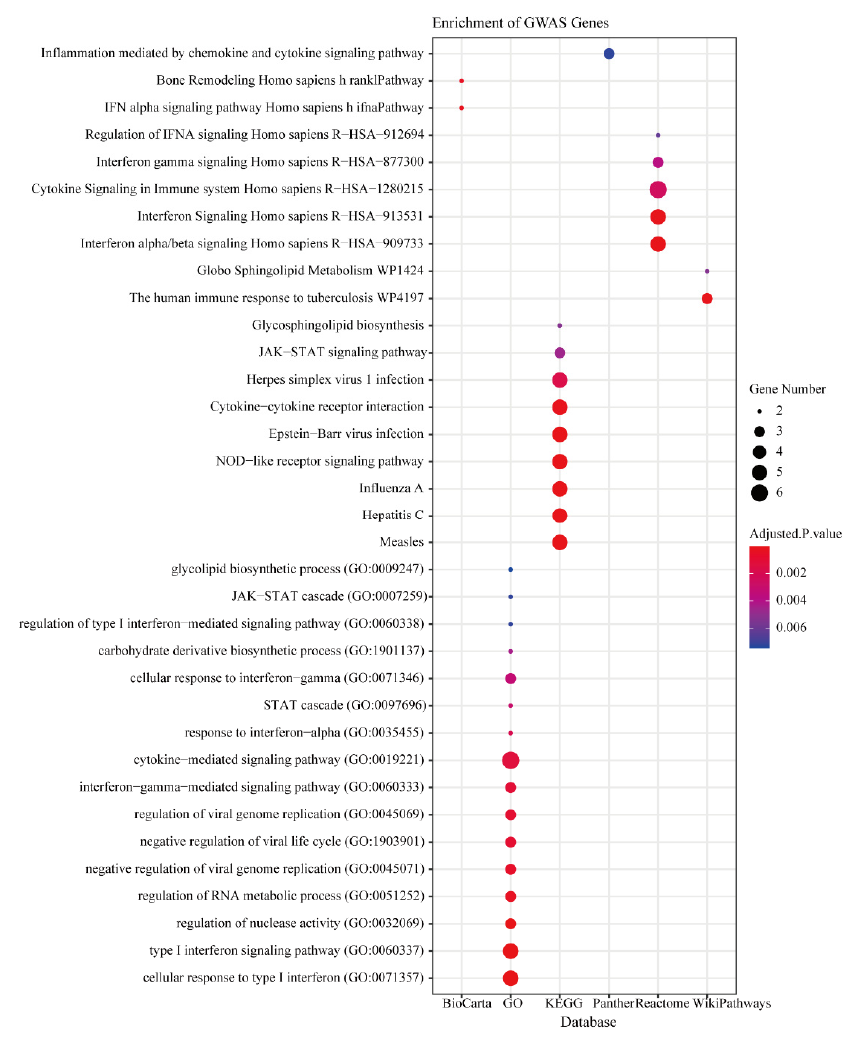
Figure 4. Results of the GSEA. Pathways and functional terms that are significantly enriched for GWAS genes.